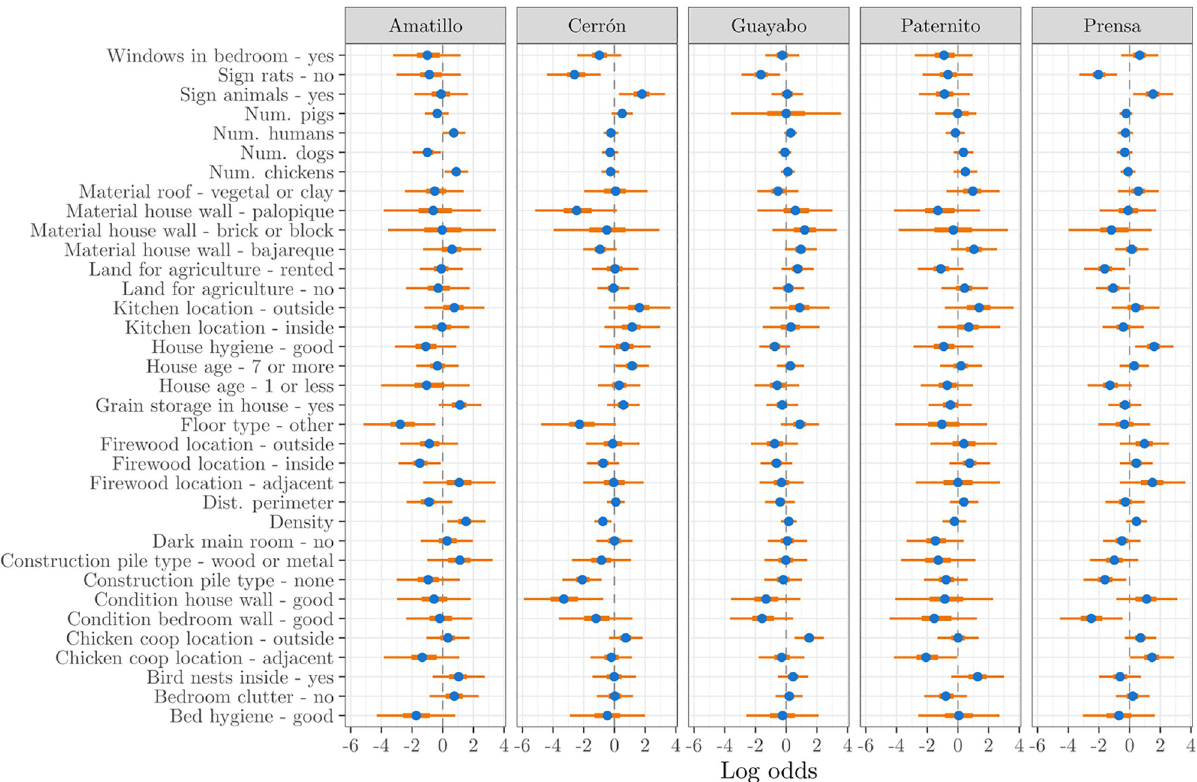
Fig 2. Fixed effect coefficients from fitting the model of Section 2.2 to all available data in each village. Coefficients are on log odds scale. The blue point is the posterior mean, the bold orange line is the 50% HPDI, and the thin orange line is the 95% HPDI.